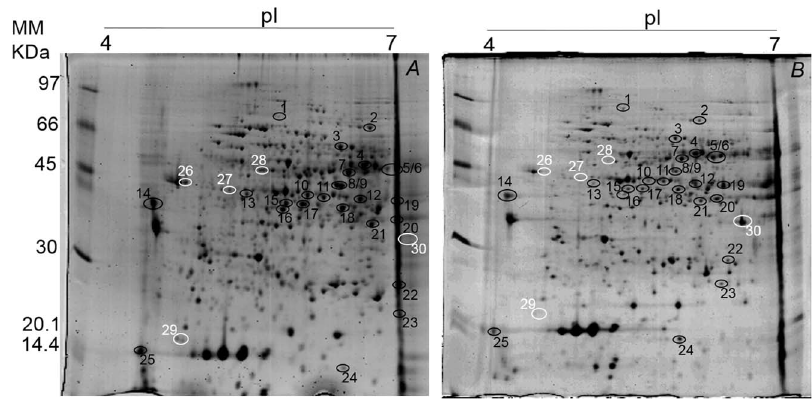
Figure 6. Two-dimensional gel of proteins from roots of the TSH-774 clonal genotype of Theobromacacao subjected to 96 h of soil flooding. A - control and B - flooded. Each gel was loaded with 350 m g of total protein and stained with 0.08% w/v colloidal Coomassie G-250. Black circles indicate spots differentially expressed between control and flooded treatments, whereas white circles indicate spots exclusive to one of the treatments in response to soil flooding.